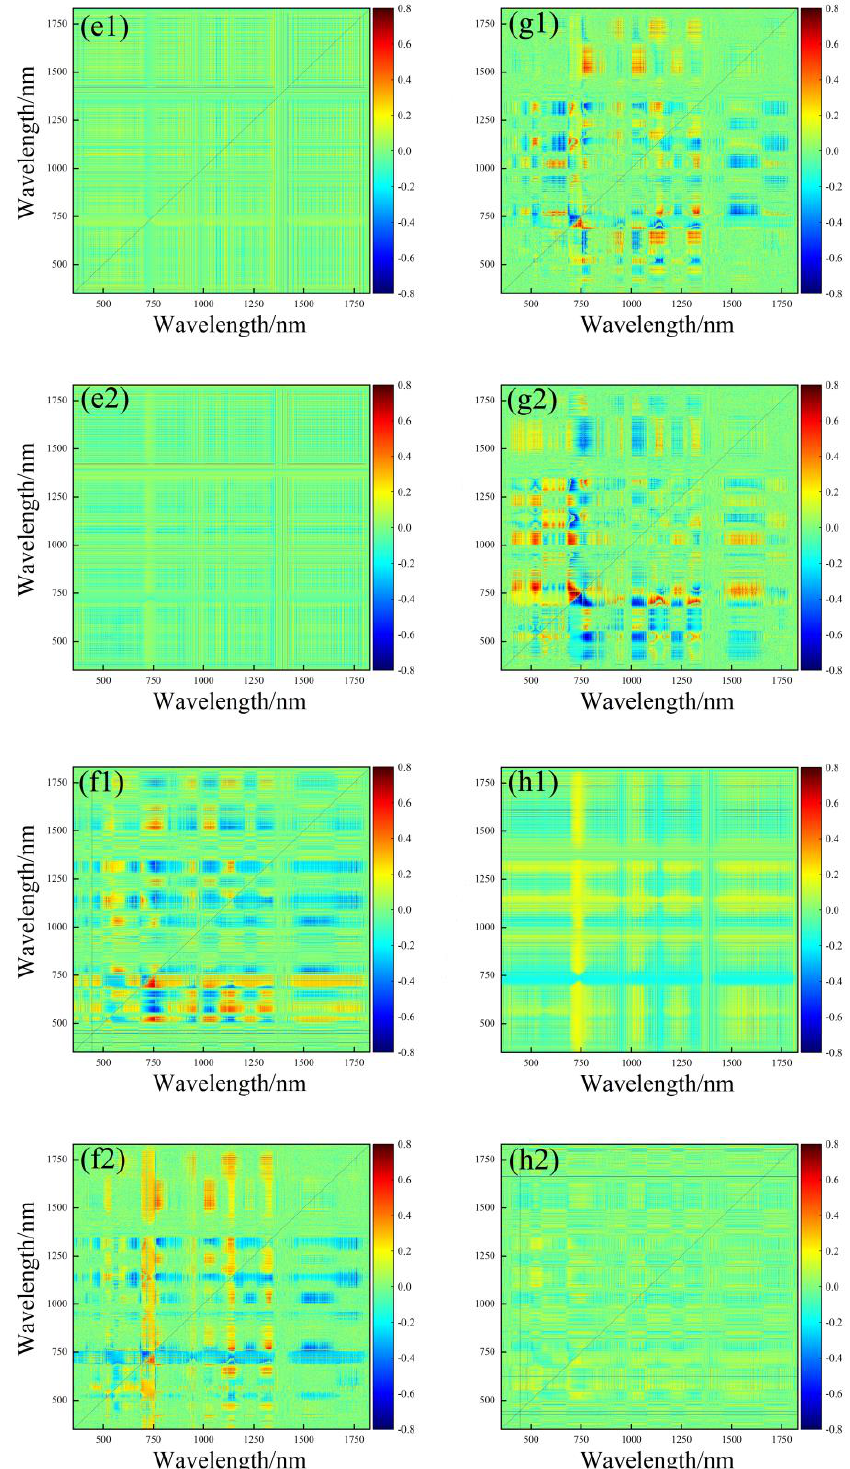
Figure 6. Correlation matrix diagram of spectral index and soybean chlorophyll content at different growth stages (( e1 , e2 ): V4 growth period DI and TVI and chlorophyll content correlation matrix diagram; the correlation matrix of mSR and mNDI with chlorophyll content in ( f1 , f2 ): R2 growth period; ( g1 , g2 ): R4 growth period mNDI and NDVI and chlorophyll content correlation matrix; ( h1 , h2 ): R6 growth period TVI and mSR and chlorophyll content correlation matrix).